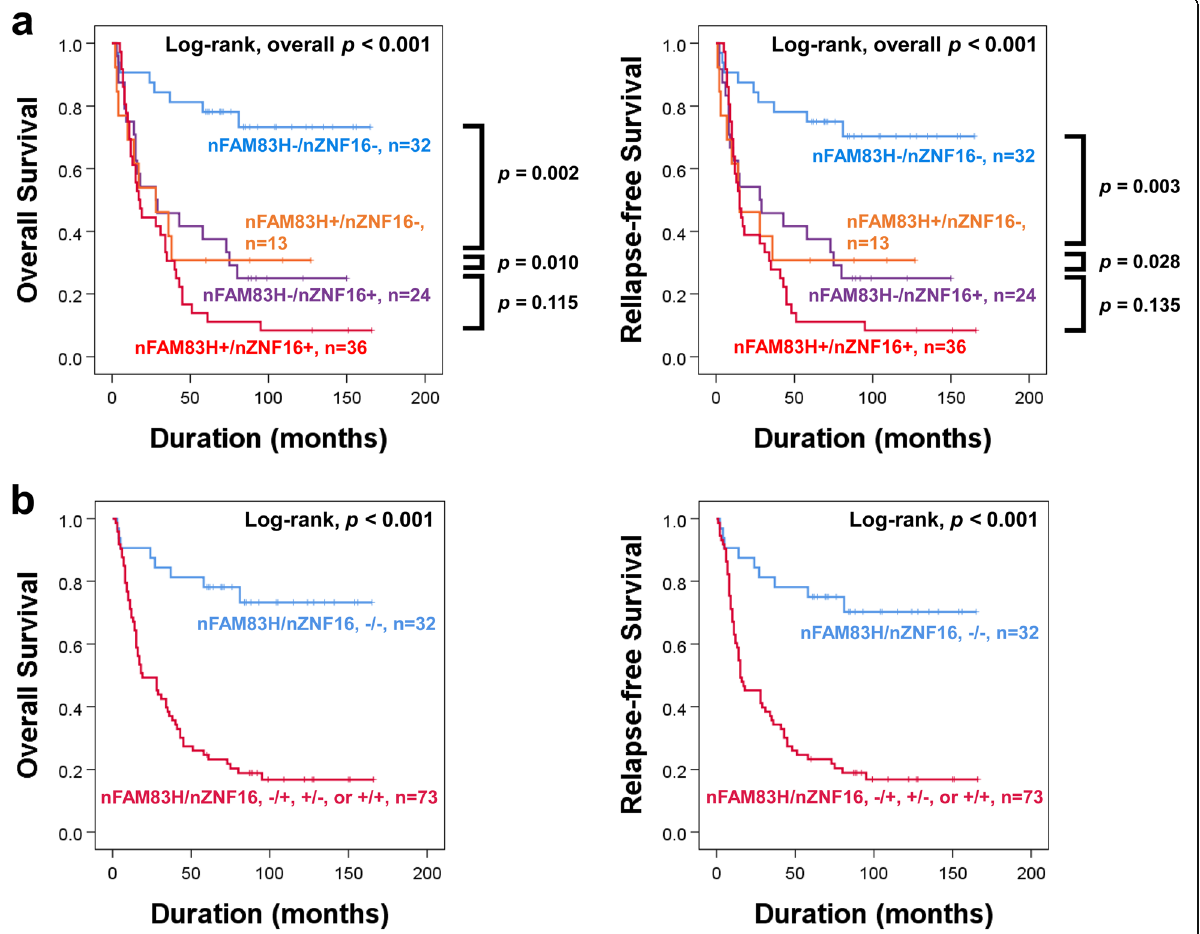
Fig. 3 Survival analysis according to co-expression patterns of nuclear FAM83H and nuclear ZNF16 in gallbladder carcinoma patients. a Survival analysis for overall survival and relapse-free survival in four subgroups of gallbladder carcinoma according to the expression of nuclear FAM83H (nFAM83H) and nuclear ZNF16 (nZNF16): nFAM83H − /nZNF16 − , nFAM83H − /nZNF16 + , nFAM83H + /nZNF16 − , and nFAM83H + /nZNF16 + subgroups. b Survival analysis for overall survival and relapse-free survival in two groups of gallbladder carcinomas: [nFAM83H − /nZNF16 − ] and [nFAM83H −